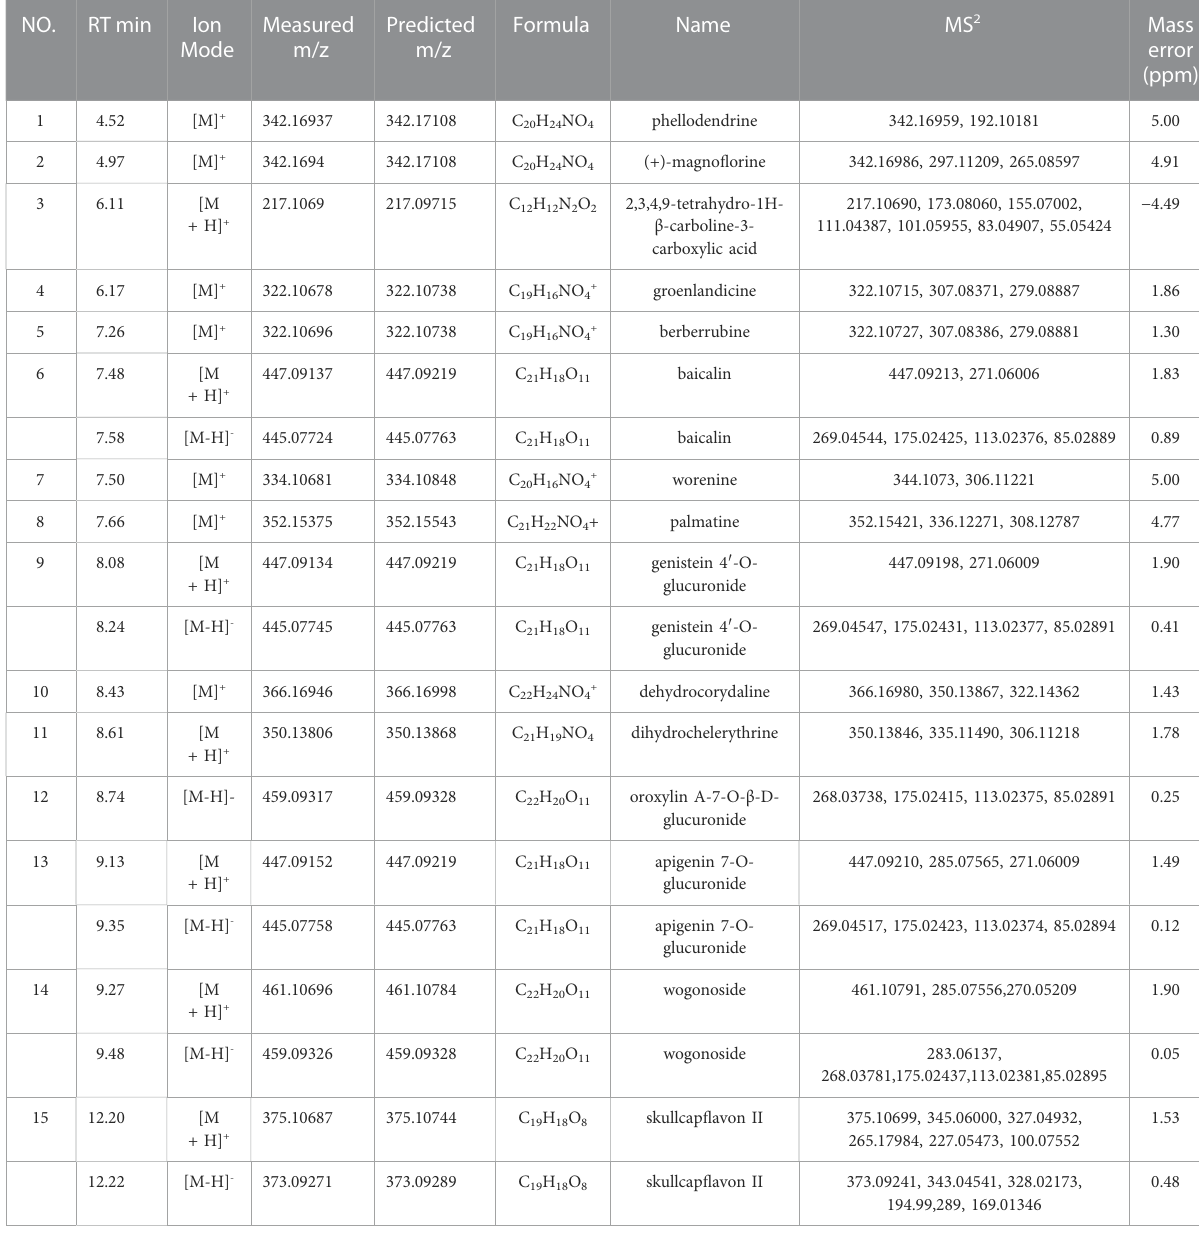
TABLE 1 Identi fi cation of the speci fi c binding component of Huanglian Jiedu decoction by UPLC-Orbitrap Fusion TMS. NO. RT